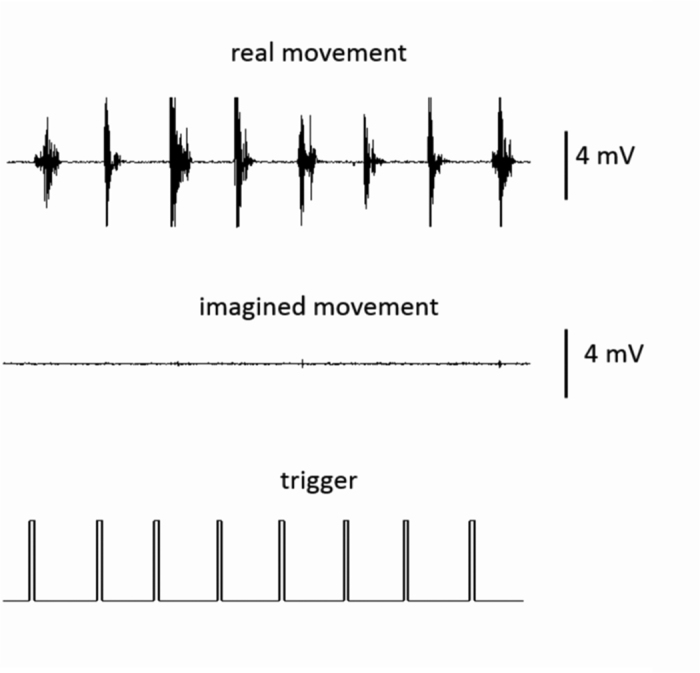
A representative electromyogram amplitude during real and imagined movements.Robust muscle activities were observed during the real movement, but not during imagined movement, after the presentation of the execution cue (trigger).